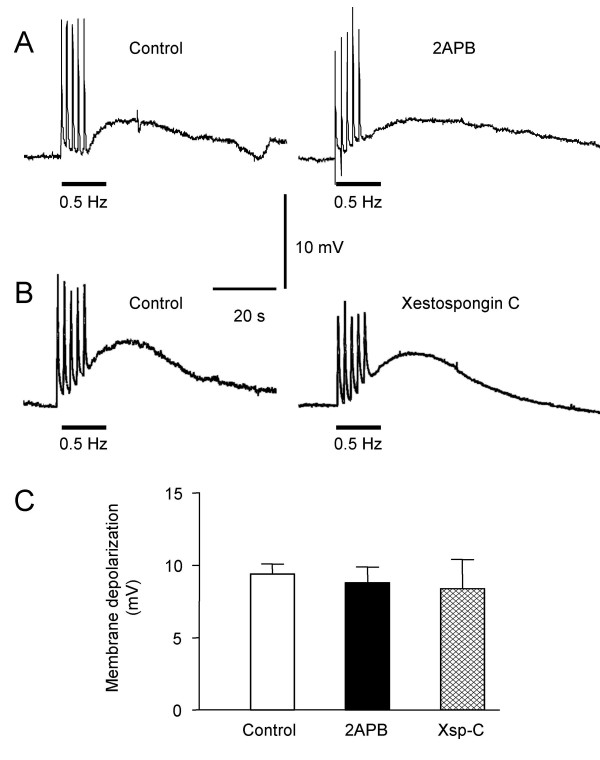
2APB and xestospongin C have no effect on the EFS-induced slow membrane depolarization of canine isolated mesenteric vein. Intracellular recordings of membrane potential in response to EFS (0.1 ms, 13 V, 10 s, 0.5 Hz) in canine isolated mesenteric veins preincubated for 60 min prior to and throughout the experiment with 50 μM 2APB (A) or 30 μM xestospongin C (B). The experimental data are presented as mean ± SEM, n = 3–4 (C). Scale bars apply to traces A and B.